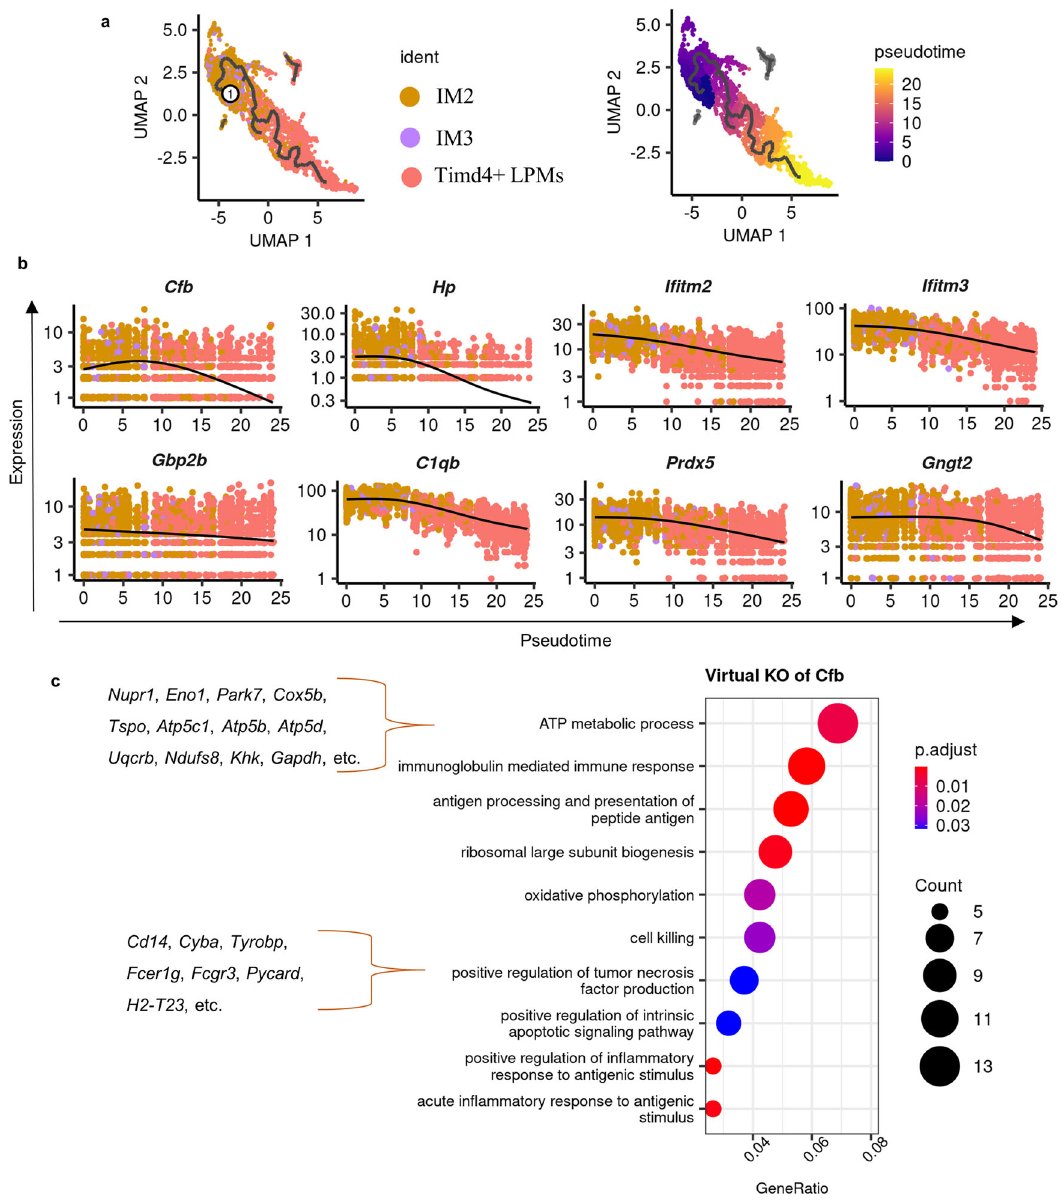
Fig. 6 Reconstruction of a pseudo-temporal trajectory for maturation of intermediate “ large ” macrophages. a UMAP shows selected cells of “ large ” macrophages (left) and a trajectory path built by Monocle 3 (right). The selected root cell was labelled as ① . b Dynamic changes of genes along this trajectory path of maturation and replenishment. c GO terms of biological processes that were enriched by perturbed genes affected by virtual KO of Cfb